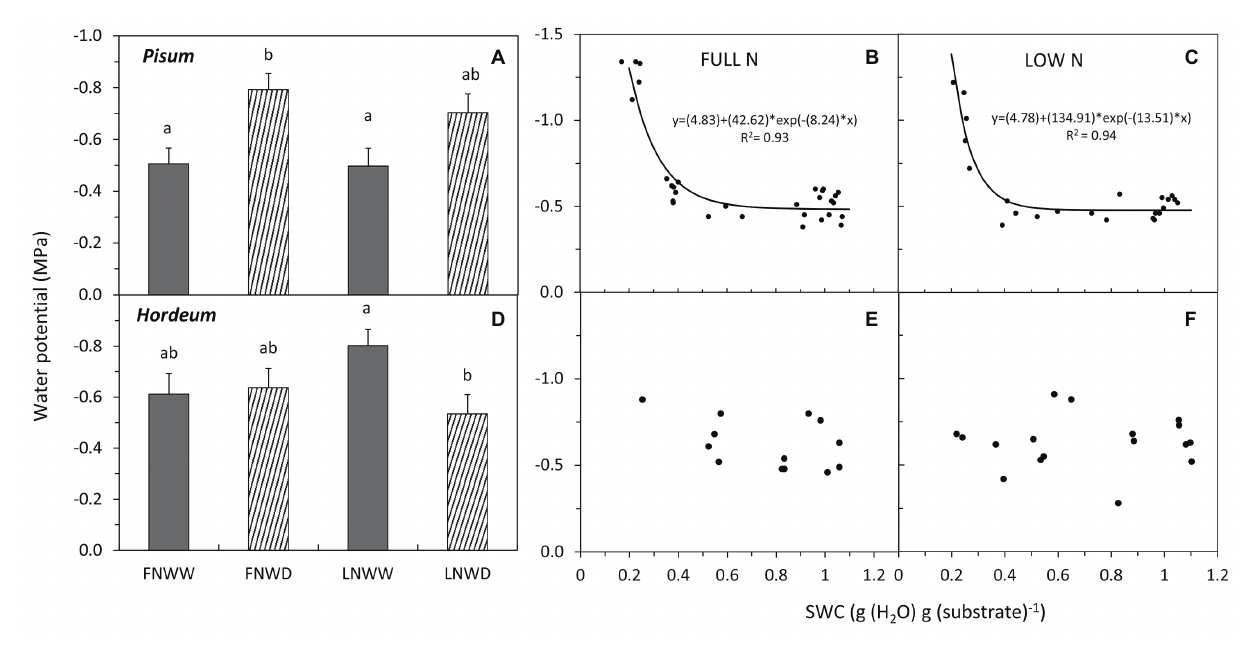
FIGURE 3 | Mean water potential (WP) of P. sativum (A,B,C) shoots and H. vulgare (D,E,F) leaves after 2–6 days treatment with different water and nitrogen availability. FNWW plants received 4 mM NO3 − daily, FNWD plants received 4 mM NO3 − at the start but no water during the sampling period, LNWW plants received 0.2 mM NO3 − daily, and LNWD plants received 0.2 mM NO3 − at the start but no water during the sampling period. The graph (A,D) shows means in each treatment ± SE (n = 6–17). Significant differences ( p ≤ 0.05) between treatments were tested separately for each species and are marked by different letters. Dynamic changes of WP with declining substrate water content (SWC) are shown in (B,C) for P. sativum; (E,F) for H. vulgare under full NO3 − (FN) and low NO3 − (LN) availability. Significant relationships are marked by a regression line with the corresponding equation. FN, full nitrogen; LN, low nitrogen; WW, well-watered; and WD, water